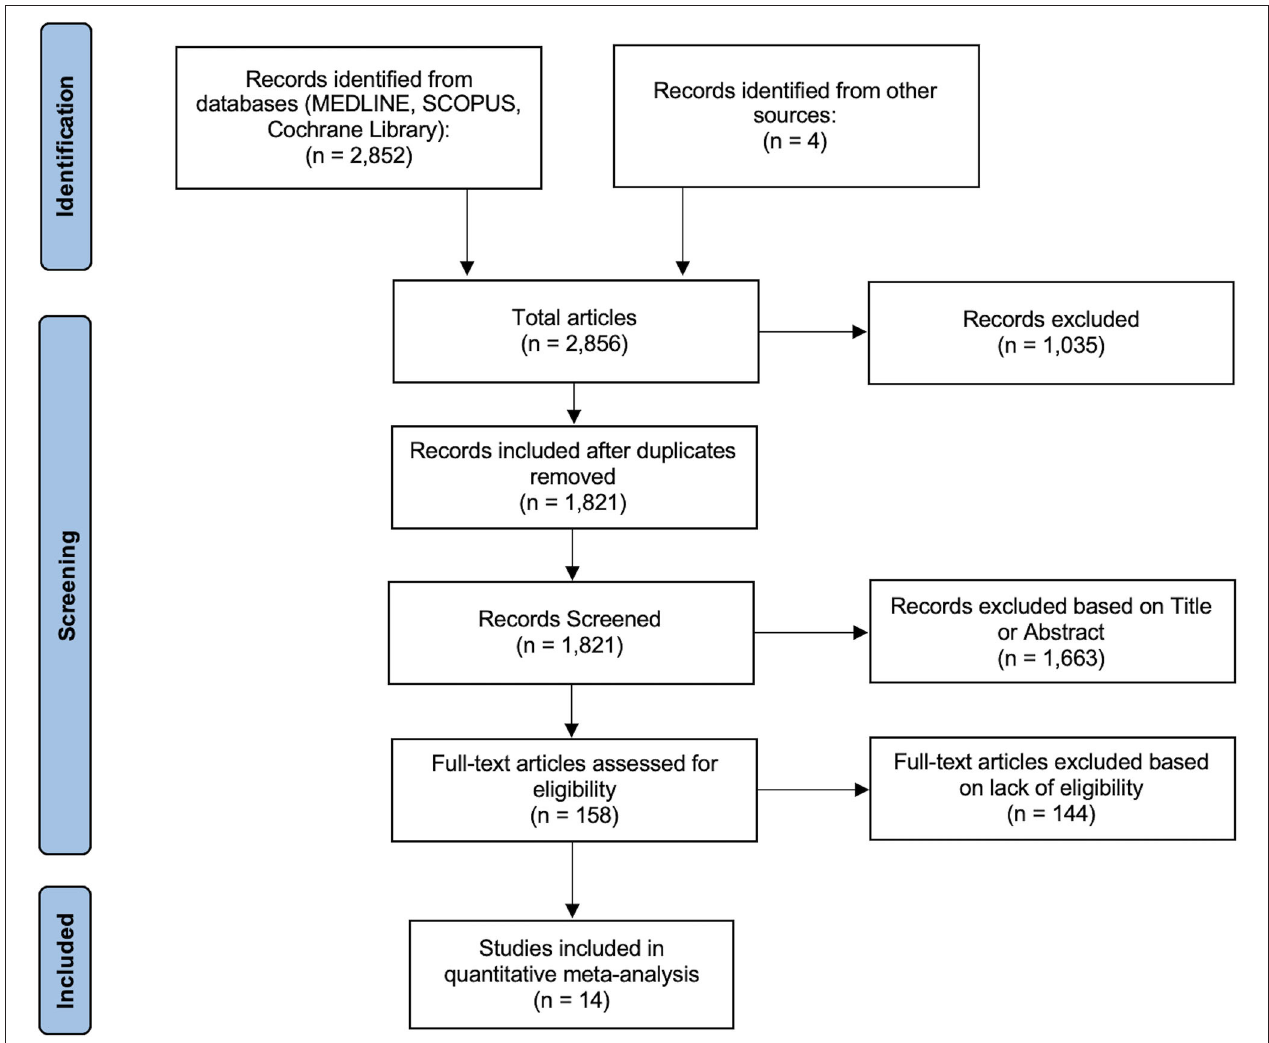
FIGURE 1 | PRISMA flow diagram. This diagram demonstrates the systematic method used for the identification, screening, and inclusion of articles that met criteria for inclusion within the